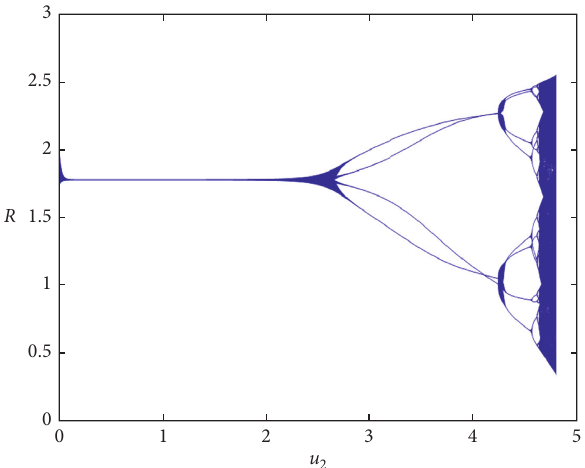
Figure 2: Bifurcation diagram with respect to u